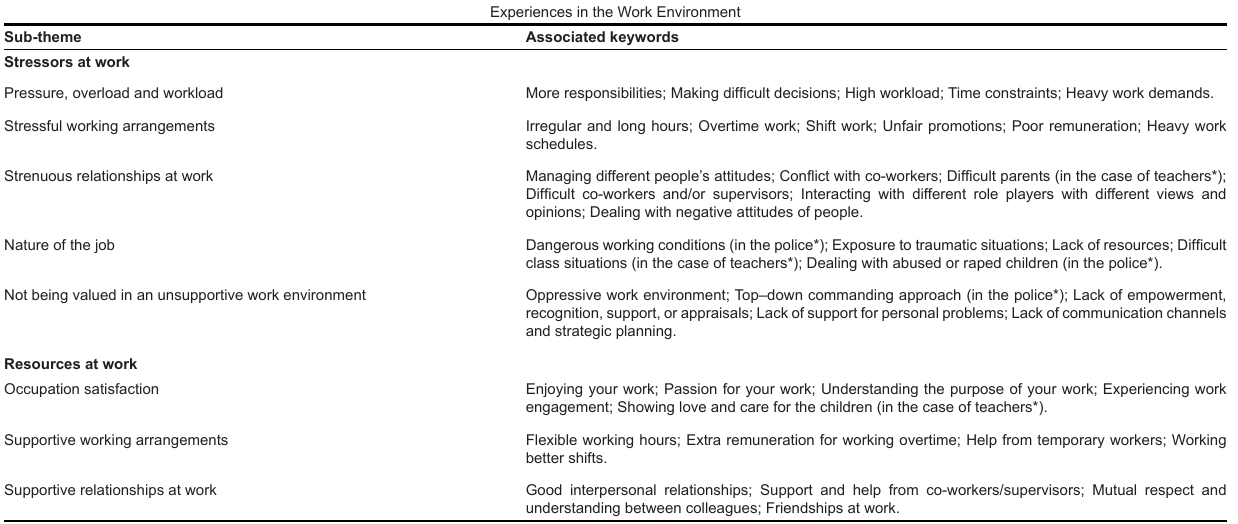
TABLE1 Experiences in the Work